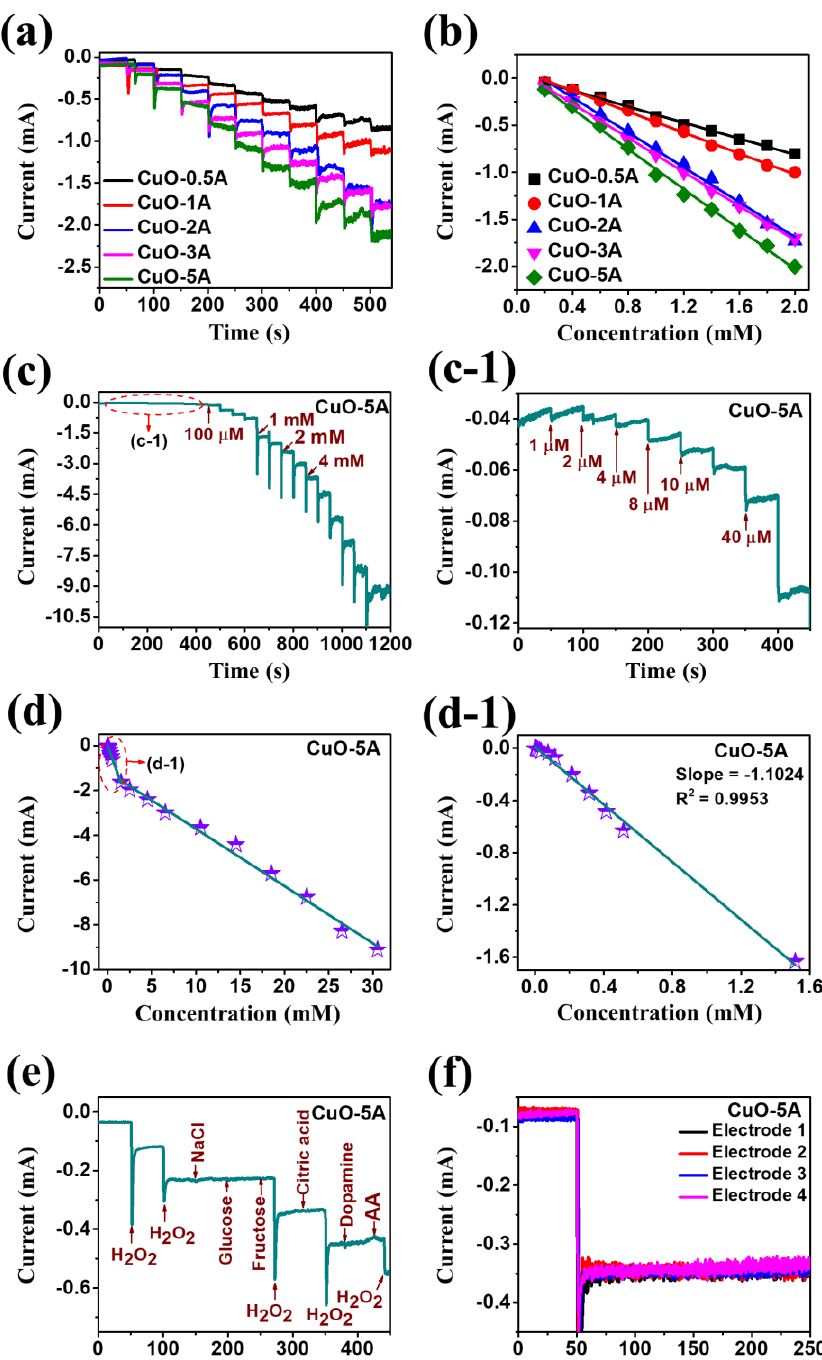
Figure 7. ( a ) Steady-state relation between current and time of current variation set upon successive addition of 0.2 mM H 2 O 2 in the N 2 -saturated 0.1 M PBS (pH 7.4) at an applied potential of − 0.4 V. ( b ) The corresponding calibration curves for H 2 O 2 detection. ( c , c-1 ) Amperometric response of CuO-5A upon dropwise addition of various H 2 O 2 concentrations from 1 µM to 4 mM. ( d , d-1 ) Calibration curve of current versus H 2 O 2 concentration at different H 2 O 2 concentration range. ( e ) Selectivity response of CuO-5A sample upon addition of 0.1 mM H 2 O 2 , NaCl, glucose, fructose, citric acid, dopamine and ascorbic acid (AA) to 0.1 M PBS (pH 7.4). ( f ) Reproductivity test of CuO-5A samples 1−4 in the 0.1 M PBS (pH 7.4) at the potential of −0.4 V. Table 1. Comparison of electrochemical H 2 O 2 sensing performance for the CuO-based materials.